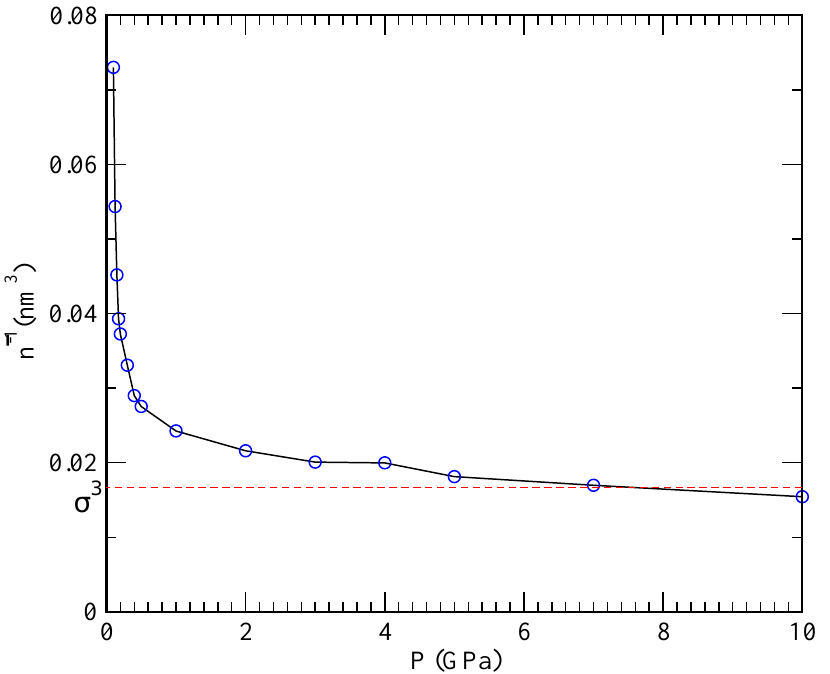
Figure 4. Specific volume n − 1 as a function of the pressure in a wide range of pressures P (0.1–10 GPa). Symbols: results of the simulation, with the error bars smaller than the symbol size. Dashed line: hard-wall volume associated with the Van der Waals radius σ of lithium and helium (both are ∼ 2.5